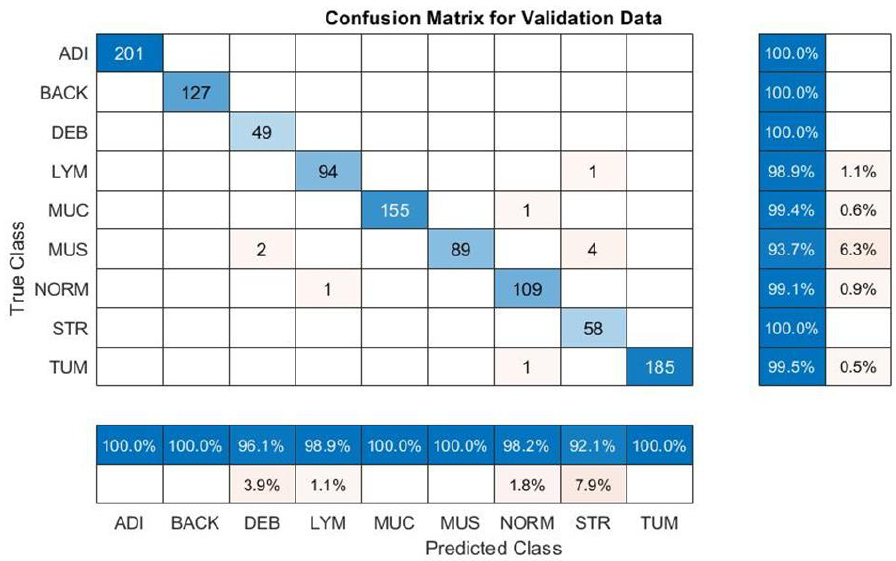
Figure 8. Experiment I: the accuracy of nine classes (CRC-VAL-HE-7K).